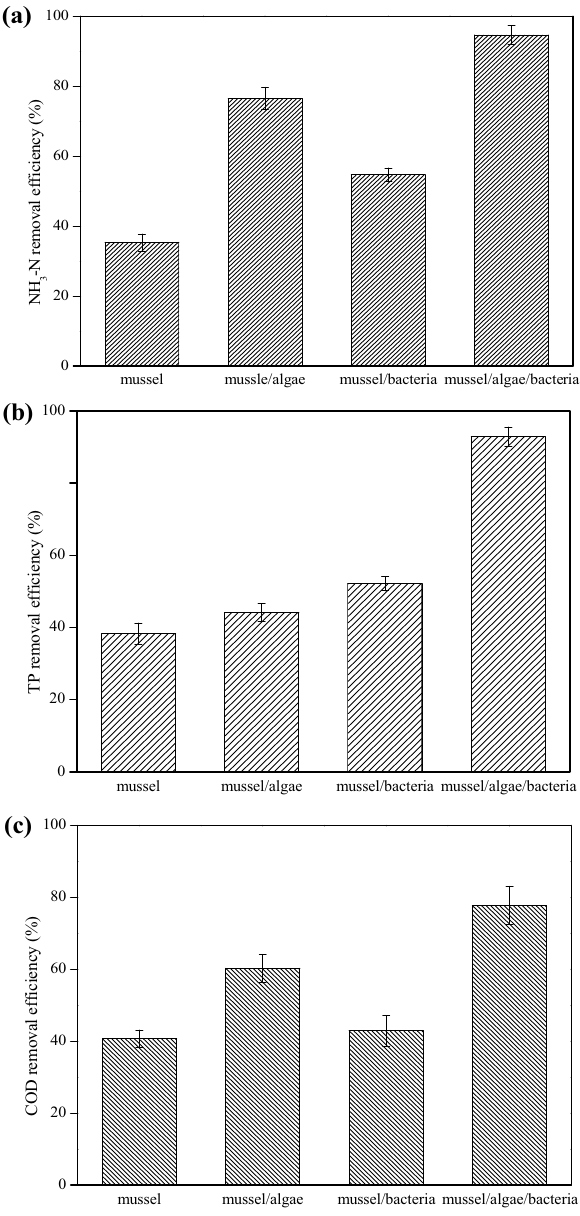
Figure 4. ( a ) NH 3 -N, ( b ) TP, and ( c ) COD removal ability in four different